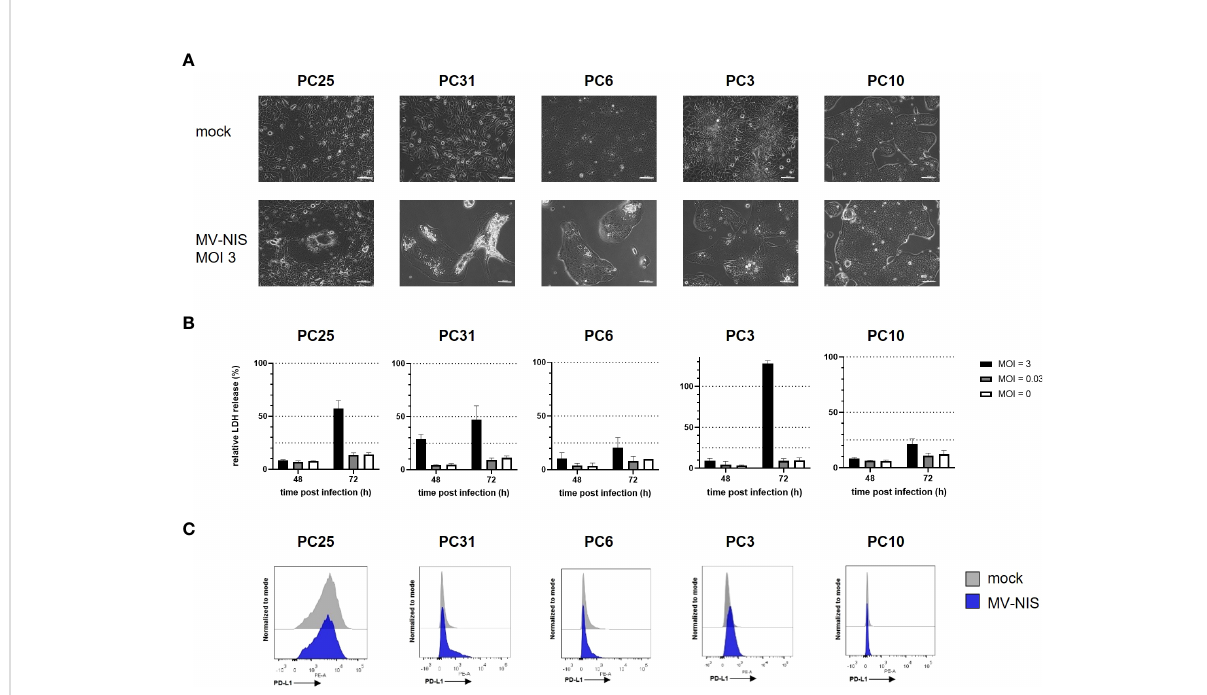
FIGURE 1 MV-NIS treatment and PD-L1 expression of patient-derived PDAC cultures. Patient-derived PDAC cultures were infected with MV-NIS at a multiplicity of infection (MOI) of 3 or subjected to mock infection. (A) Microscopic images were acquired 48 hours post infection (h p.i.). Scale bars indicate 100 μm. (B) MV-induced cytolysis was assessed by LDH release assay at 48 and 72 h p.i. Relative cytotoxicity was calculated using a 100% lysis control for each culture. Mean values and standard deviation from three replicates are shown. (C) Fourty-eight h p.i., cells were stained with a PE-labeled PD-L1 speci fi c antibody and analyzed by fl ow cytometry. Histograms depicting PE fl uorescence intensity are shown. Representative plots from n = 3 independent experiments are